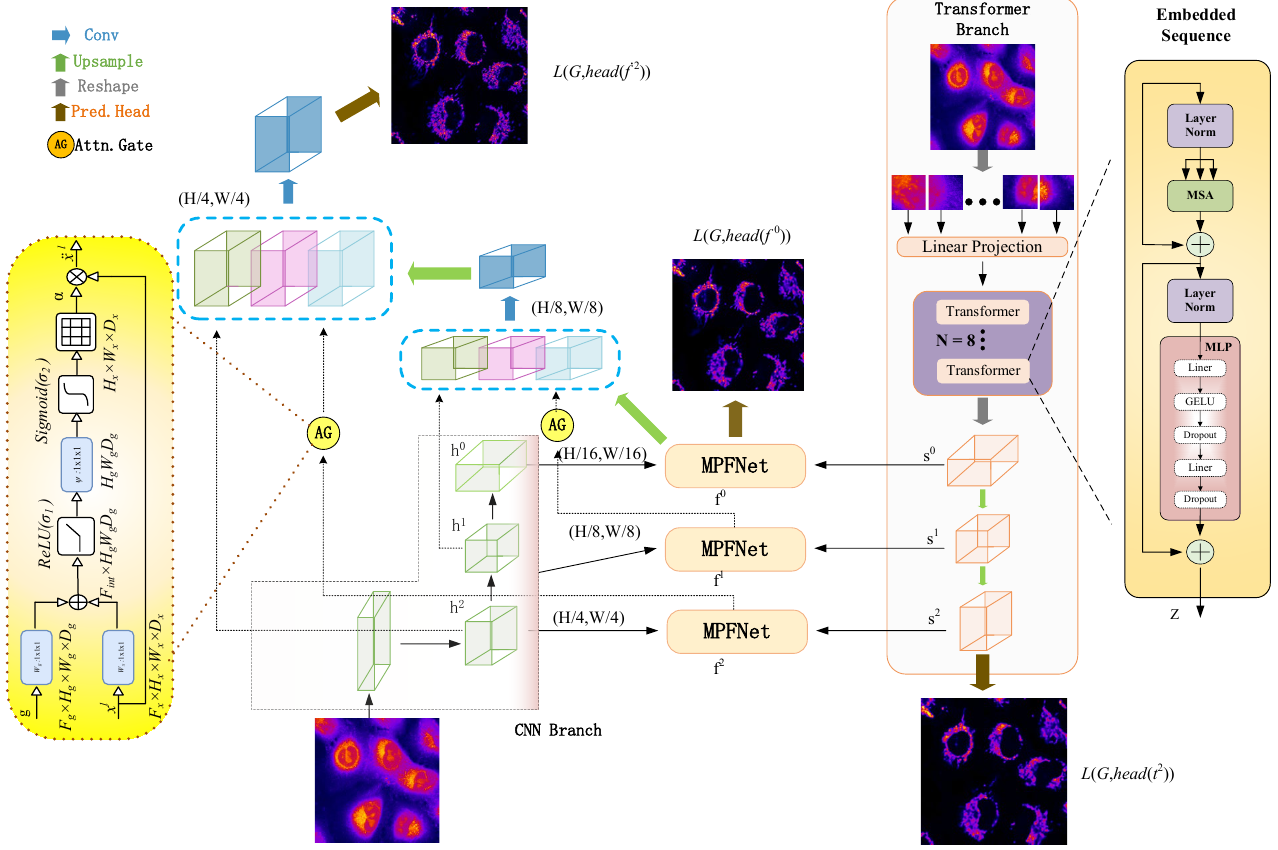
Figure 13. Multiple Parallel Fusion Deep Networks for the Protein Subcellular Localization from Label-free live cell imaging.